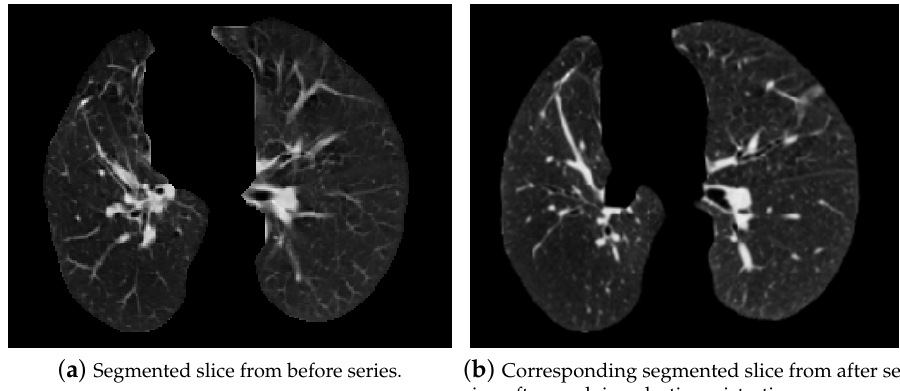
Figure 19. Illustration of the elastic registration using the SimpleITK